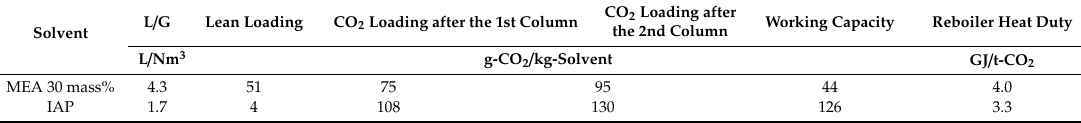
Table 7. CO 2 loadings at di ff erent locations for minimum reboiler heat duty.